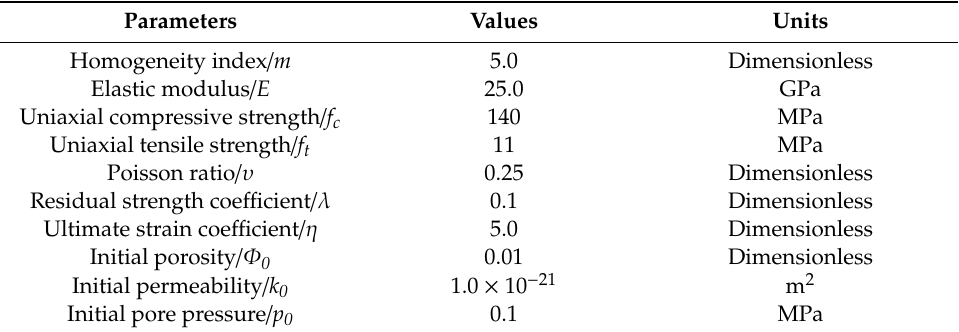
Table 4. Parameters used in the